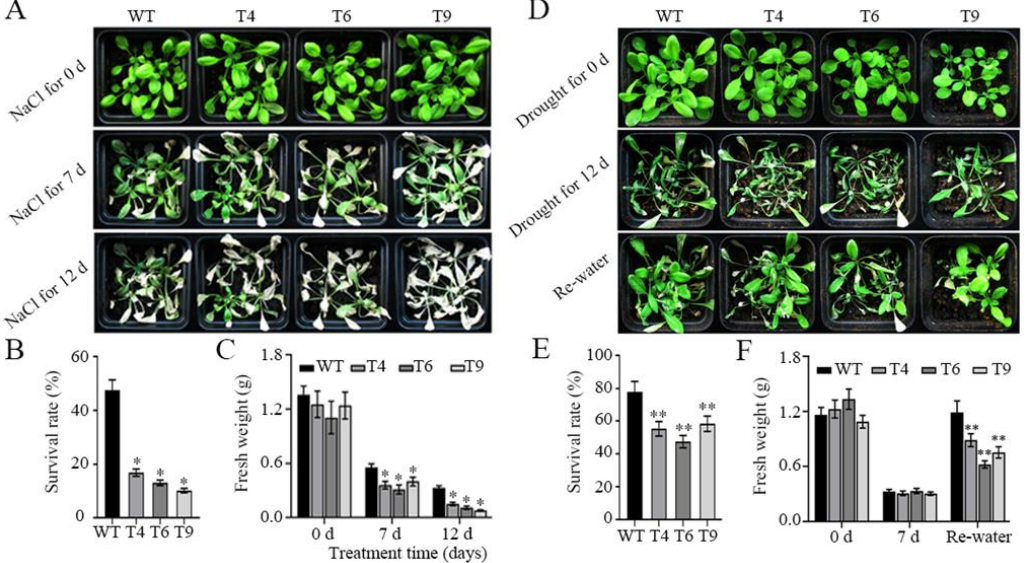
Figure 7. Stress tolerance of FtMYB22 transgenic Arabidopsis (T4, T6, and T9) lines and WT lines under salt and drought conditions. ( A ) Phenotype of FtMYB22 transgenic Arabidopsis lines under salt stress over time. ( B ) Survival rate of FtMYB22 transgenic Arabidopsis lines following the salt treatment for 12 d. ( C ) Fresh weight of FtMYB22 transgenic Arabidopsis lines under salt stress. ( D ) Phenotype of FtMYB22 transgenic Arabidopsis lines under water deficit stress for 12 d. ( E ) Survival rate of FtMYB22 transgenic Arabidopsis lines under water deficit stress for 12 d. ( F ) Fresh weight of FtMYB22 transgenic Arabidopsis lines under water deficit stress for 12 d. WT, wild-type. Data are calculated from triple experiments and presented as mean ± SD. Error bars indicate standard errors. * means extremely significant difference at p < 0.01 level, ** means extremely significant difference at p < 0.01 level.